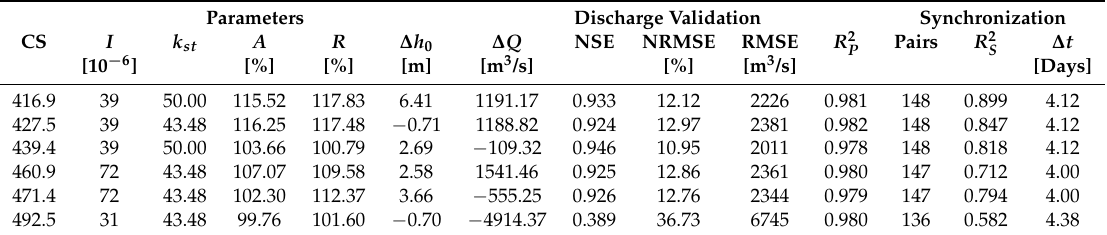
Estimated Parameters (left), discharge validation results (center), and observations synchronization statistics (right) at Tarbert Landing using combined altimetry data from J2, S7, S9, and S10. For details see Table 3.